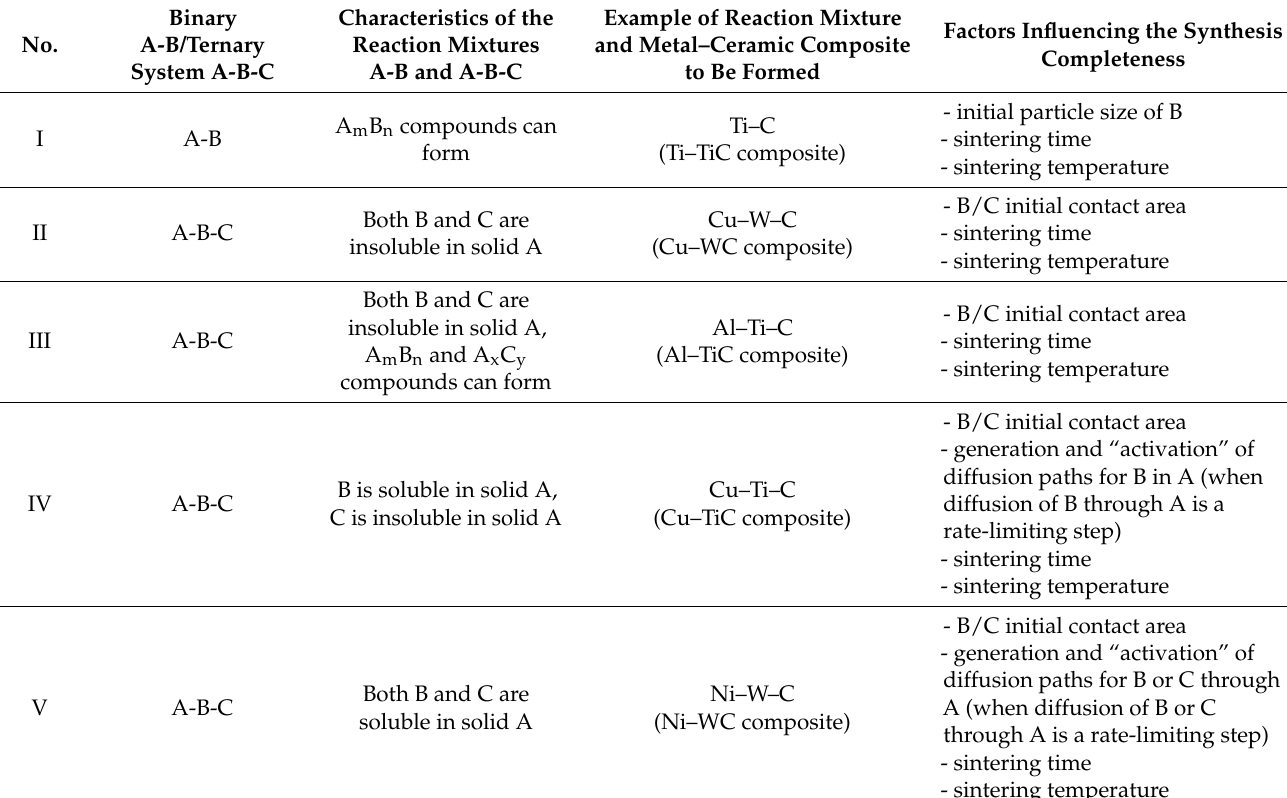
Table 1. Characteristics of A-B and A-B-C systems (reaction mixtures of elemental powders), examples of metal–ceramic composites to be produced from these mixtures, and factors influencing the synthesis completeness (formation of the desired reinforcing